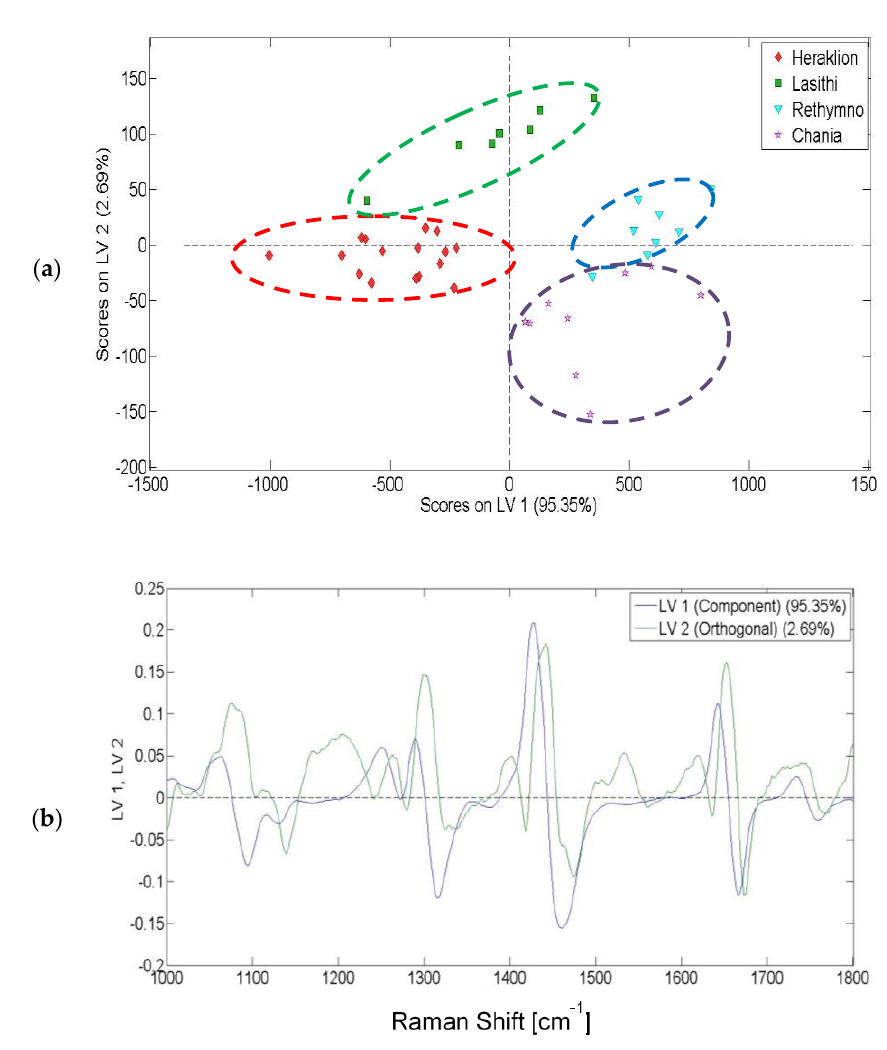
Figure 5. Classification of olive oils: ( a ) score plot for the discrimination of the olive oils from Crete using Raman spectroscopy; ( b ) loading plot based on Raman spectra. Table 4. Root mean square errors of cross-validation (RMSECV) and correlation coe ffi cients (R 2 ) in the prediction of mixtures of olive oils from di ff erent geographical regions by PLS model. Crete-Peloponnese